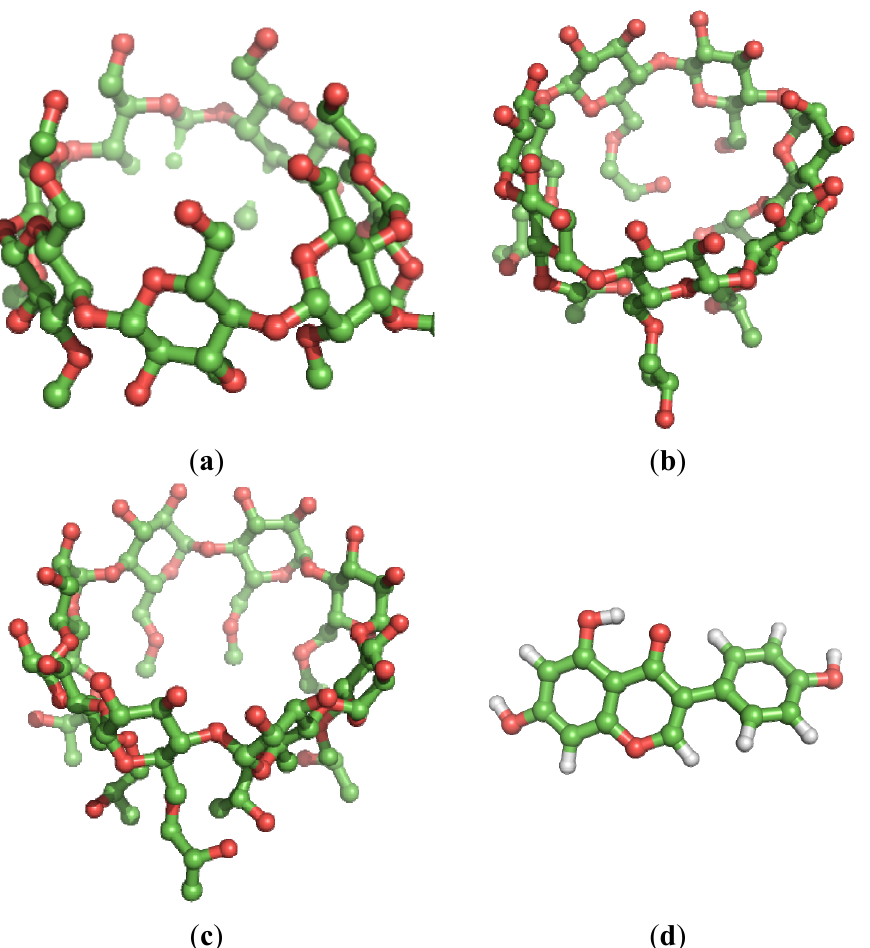
Figure 1. 3D representation of CDs clusters and Gen as follows: ( a ) RAMEB; ( b ) HPBCD; ( c ) HPGCD and ( d ) Genistein. Hydrogens are omitted for